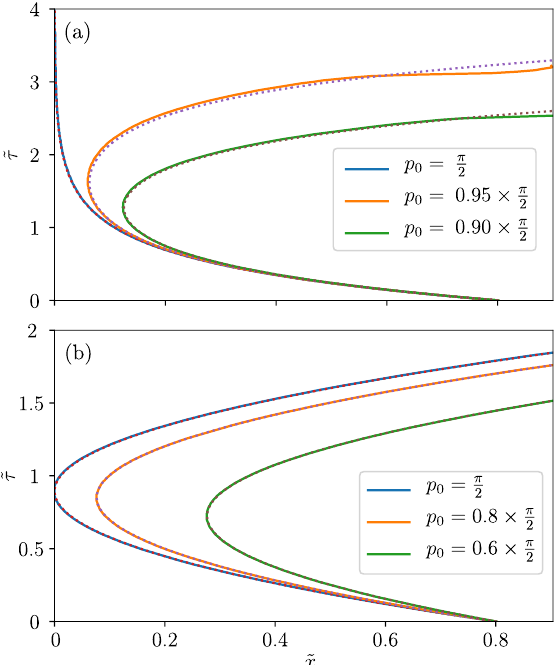
Figure 4: Peak position of Gaussian wave packets as a function of time for three values of p , and for (a) γ = 1 and (b) γ = 1 / 2, with ˜ x 0 N = 1001. The solid lines represent the numerical results, while the dashed lines represent the results obtained from the semiclassical Eqs. (31) and (32), for γ = 1 and γ = 1 / 2 respectively.